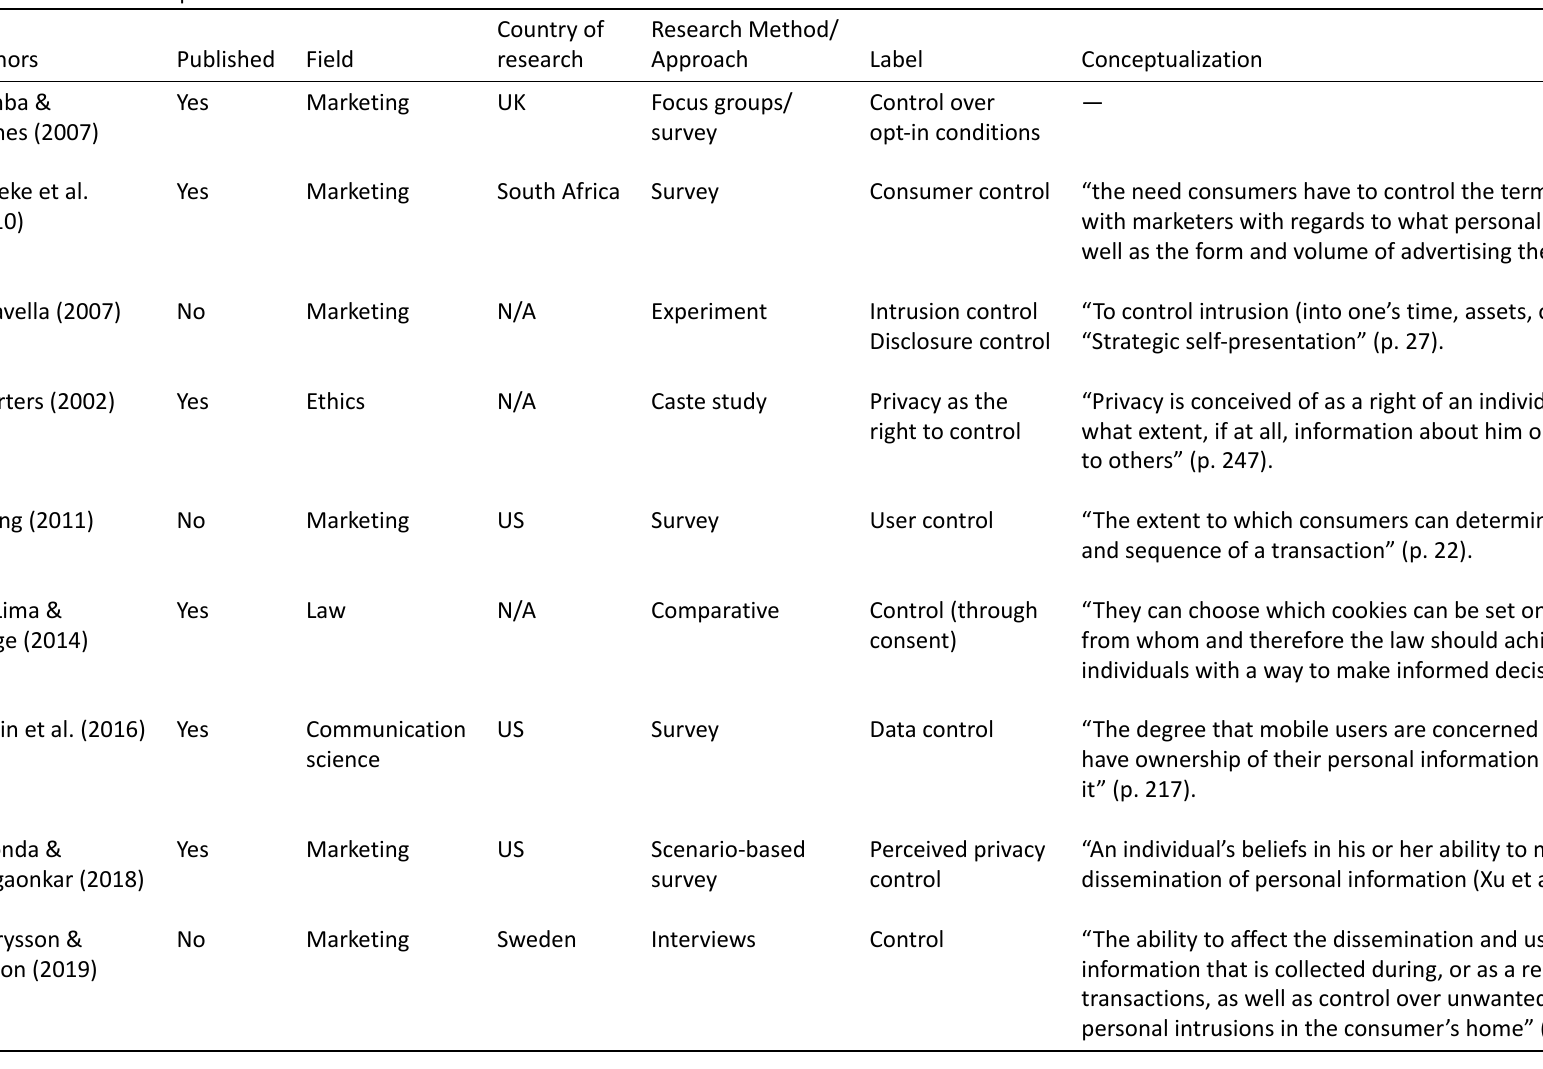
Table 2. Literature on personalization